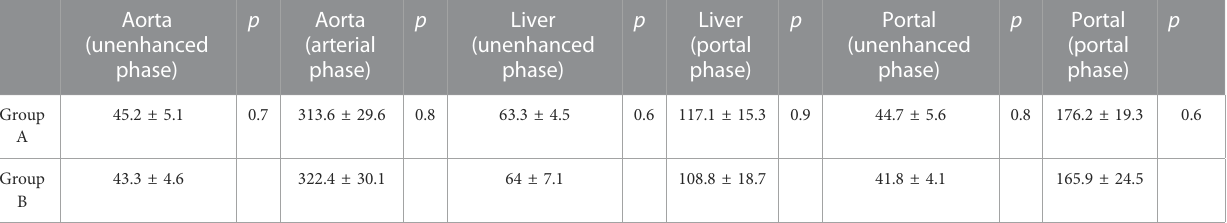
TABLE 1 Summary of the comparisons between the mean attenuation values of the key anatomical structures at different dynamic phase.